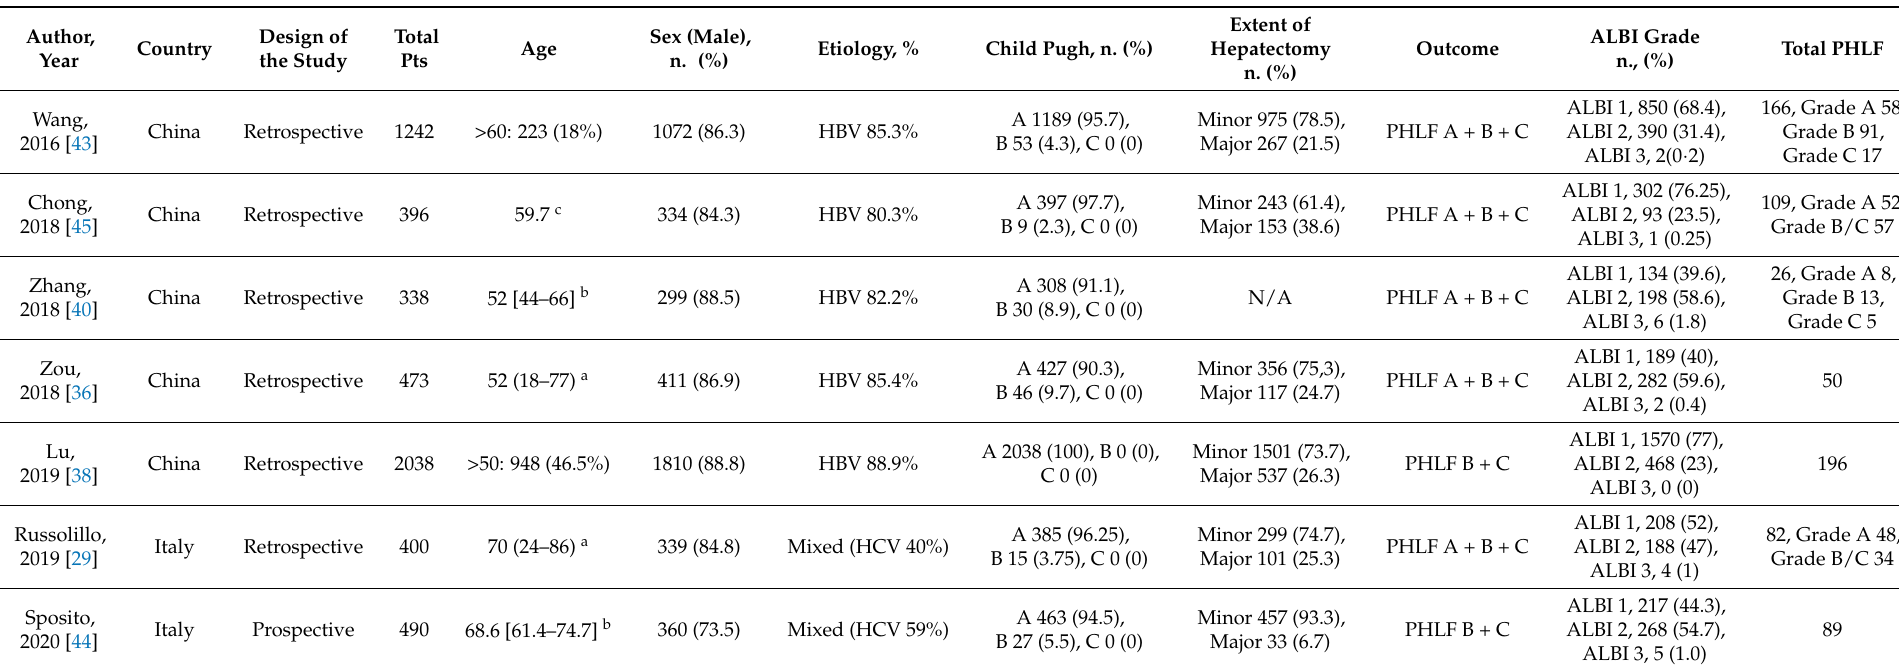
Abbreviations: pts: patients; n.: number; ALBI: Albumin-Bilirubin score; HBV: Hepatitis B Virus; HCV: Hepatitis C Virus; N/A: Not Available; and PHLF: Post-Hepatectomy Liver Failure. a = median, (range); b = median, [interquartile range]; and c =